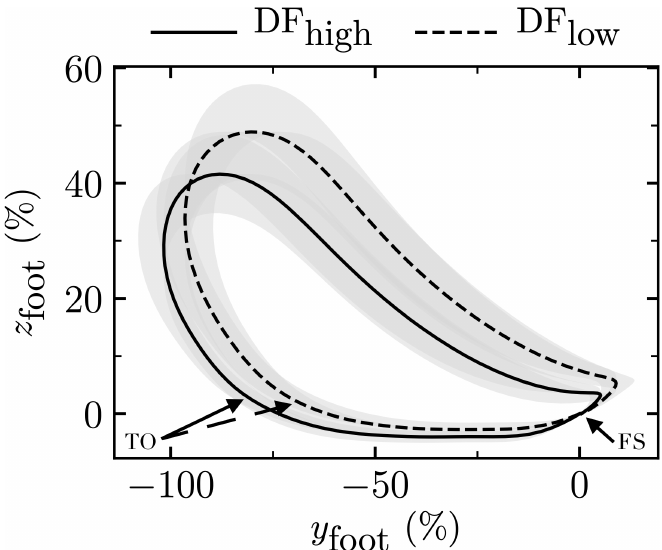
Figure 4. Running wheel for the high (DF high ) and low (DF low ) duty factor running groups while running at 14 km / h. The running wheel is defined as the vertical versus antero-posterior position of the center of mass of the foot segment, expressed as a percentage of participant’s leg length. Position (0, 0) defines the point where the center of mass of the foot segment strikes the ground. FS: foot strike and TO: toe-o ff